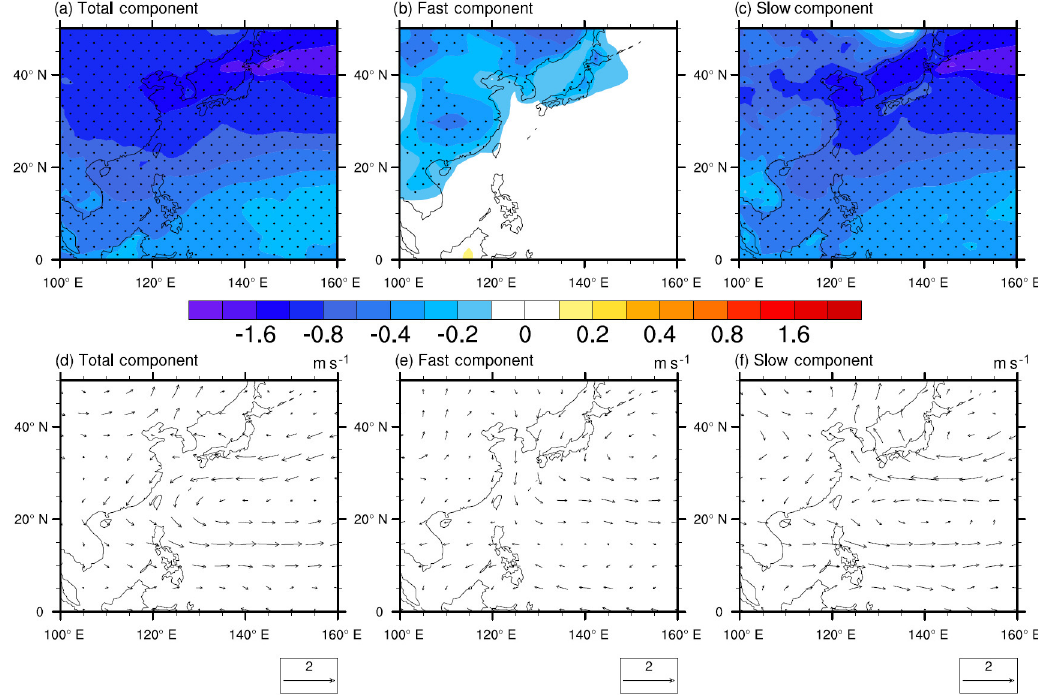
Figure 4. JJA mean total, fast, and slow responses of (a, b, c) surface air temperature (unit: K) and (d, e, f) wind vectors at 850hPa (unit: ms − 1 ) to SO 4 forcing. The dots represent significance at ≥ 95% confidence level from the t